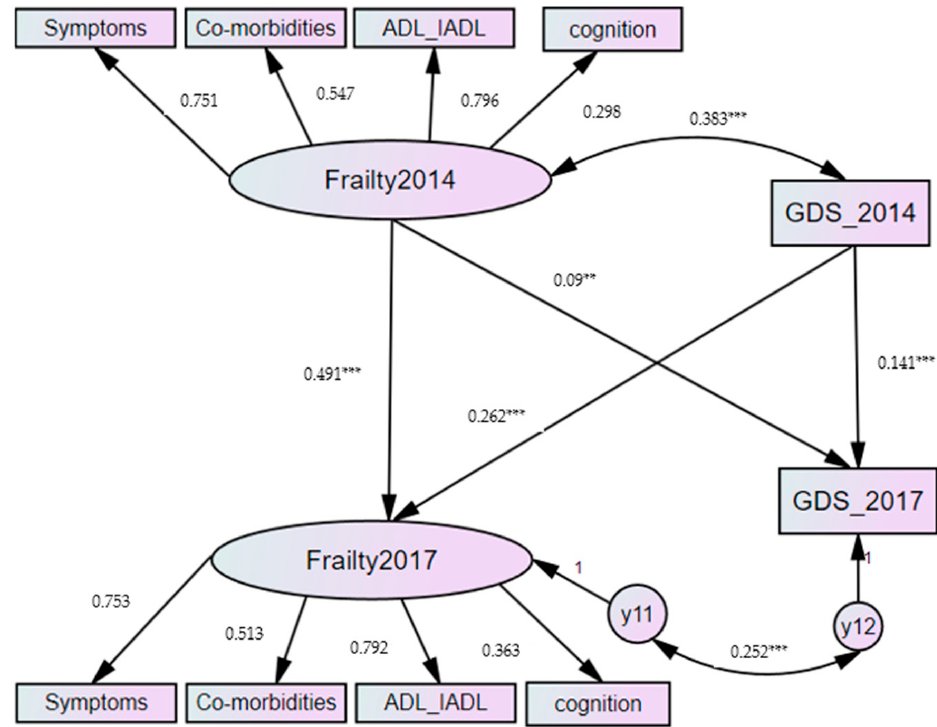
Figure 1. Results of the cross-lagged panel model. ** p < 0.01; *** p <